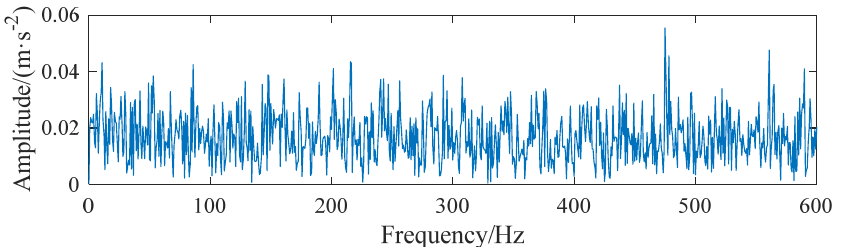
Figure 3. Simulated fault signal with noise.